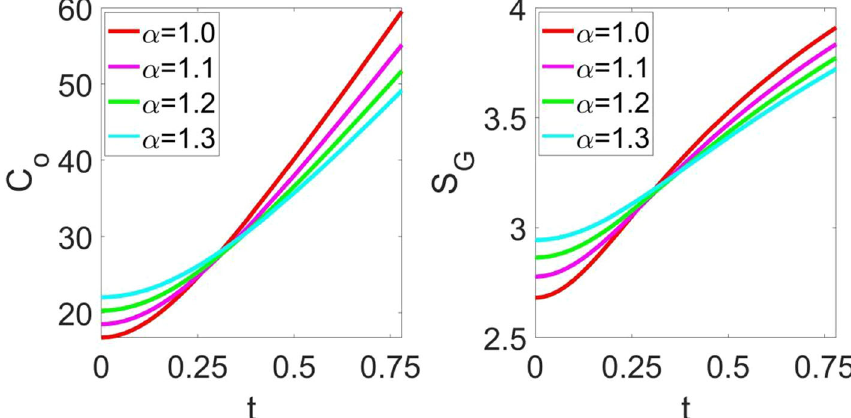
Fig. 23 Variations in the a coherence and b Gibbs entropy as functions of the time variable. The parameters are taken as: